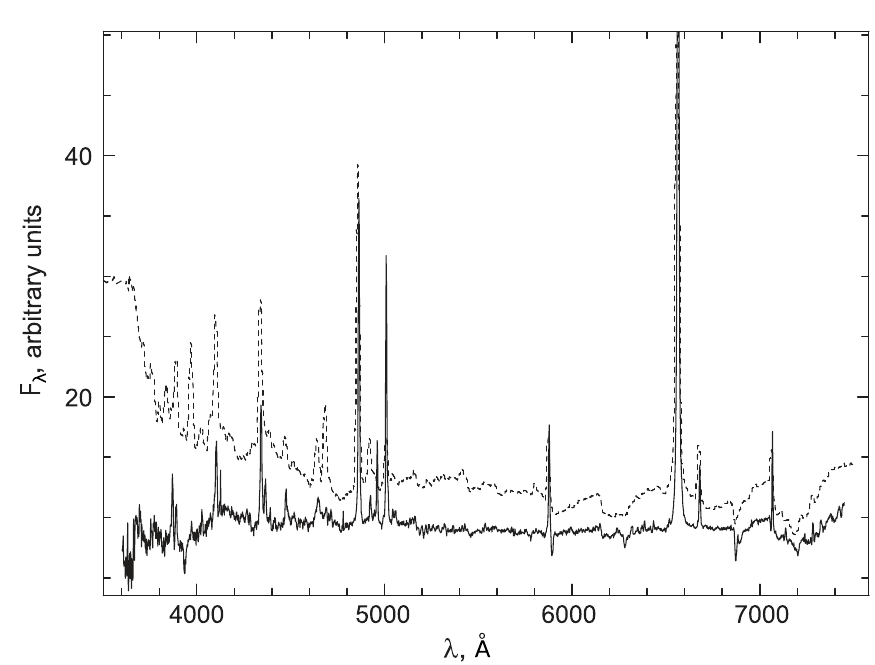
Fig. 6. Spectra of two CSS in active state: YY Her (the dashed line – Munari et al. 1997) and V1413 Aql (the solid line – Esipov et al. 2013).